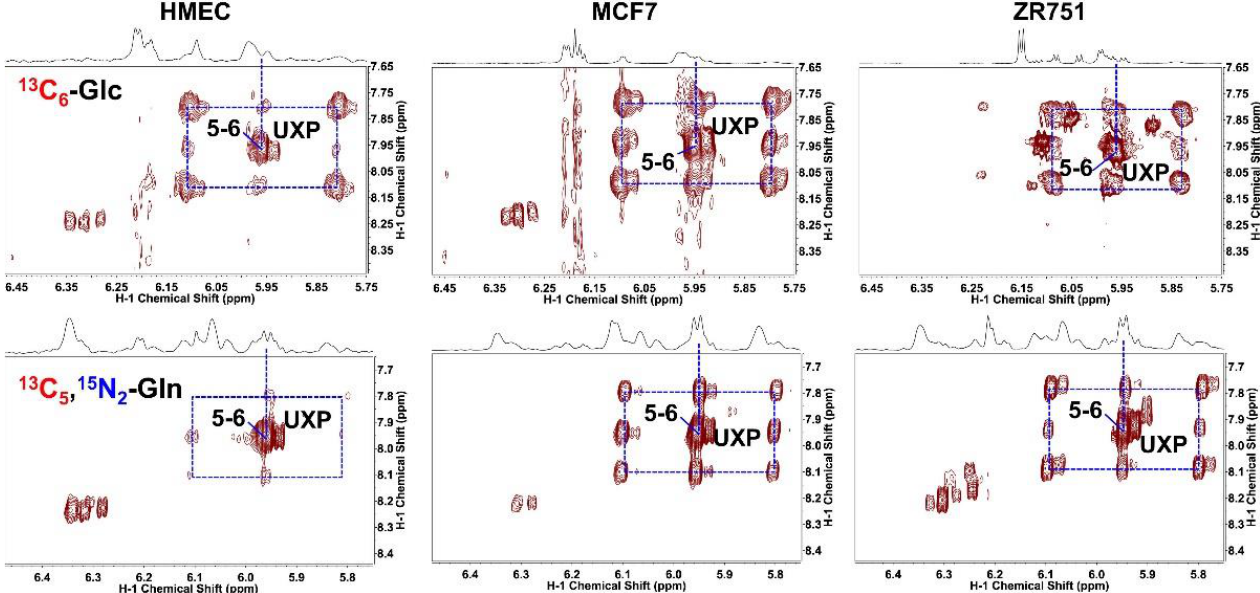
Figure 4. 13 C incorporation from 13 C 6 -glucose versus 13 C 5 , 15 N 2 -Gln into pyrimidine nucleotides in three breast cell lines. Cells were grown for 24 h in the presence of 5 mM each labelled glutamine ( top row ) or glucose ( bottom row ) compound. 2D TOCSY spectra were recorded at 600 or 800 MHz (14.1 or 18.8 T, respectively) using a mixing time of 50 ms along. The 2D TOCSY contour maps are shown along with the 1D high-resolution 1 H spectra. Dashed boxes depict the 13 C satellites of C 5 to C 6 cross-peaks of the uracil ring in UXP with horizontal pairs, vertical pairs, and 4-corner satellites representing 13 C labeling at C 5 , C 6 , and C 5,6 of uracil, respectively. Reprinted with permission from [59]. 2017, Elsevier.